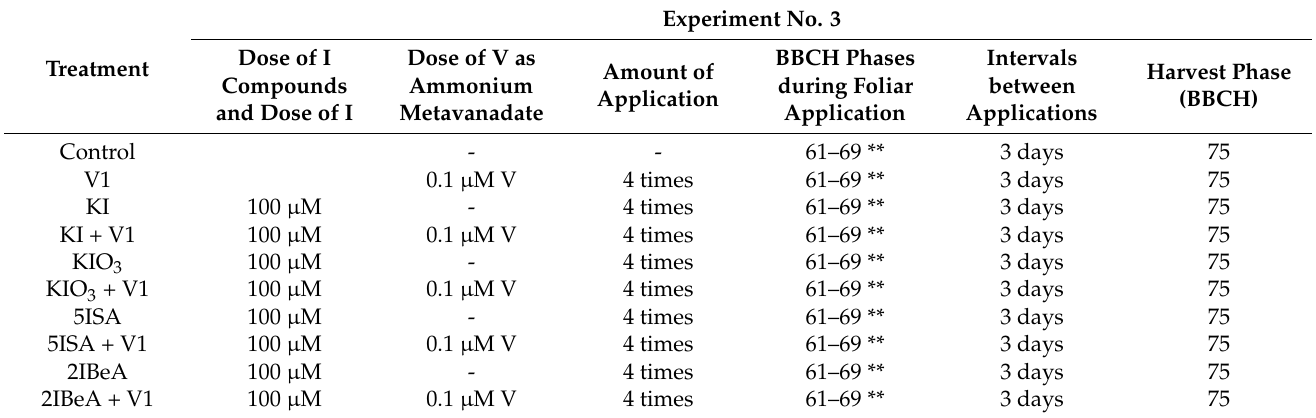
Table 7. Design and method of conducting experiments with sweet corn in field experiment No. 3